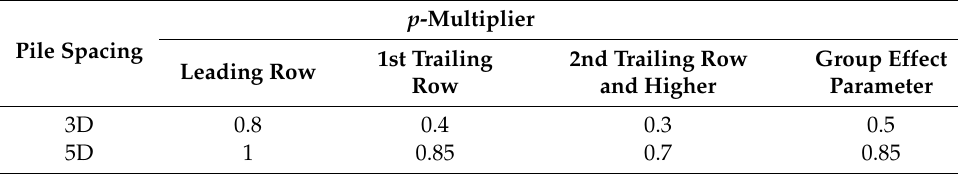
Table 6. The p -multipliers suggested in AASHTO [33].